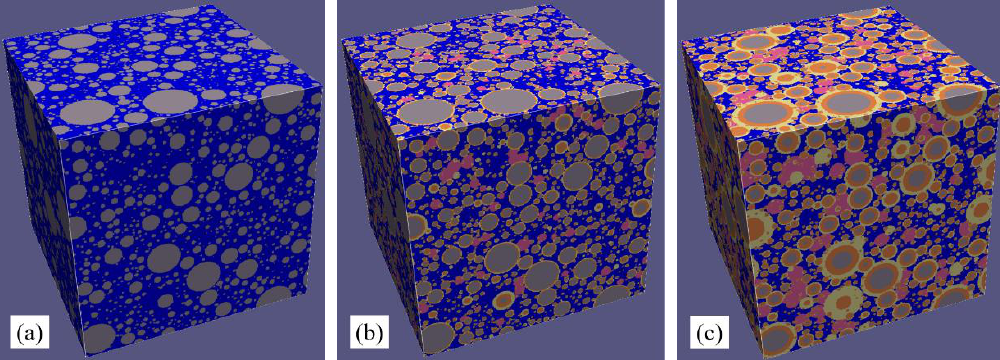
Figure 9. Microstructure of cement stone under different hydration time using HYMOSTRUC3D ( a ) 0 days; ( b ) 1 day; ( c ) 28 days.